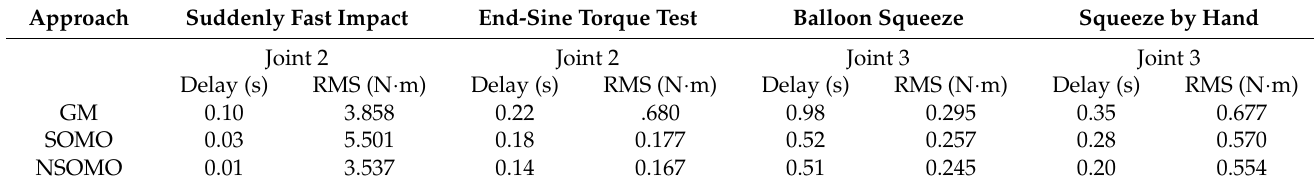
Table 3. Comparison of collision detection delays and RMS with different observers.